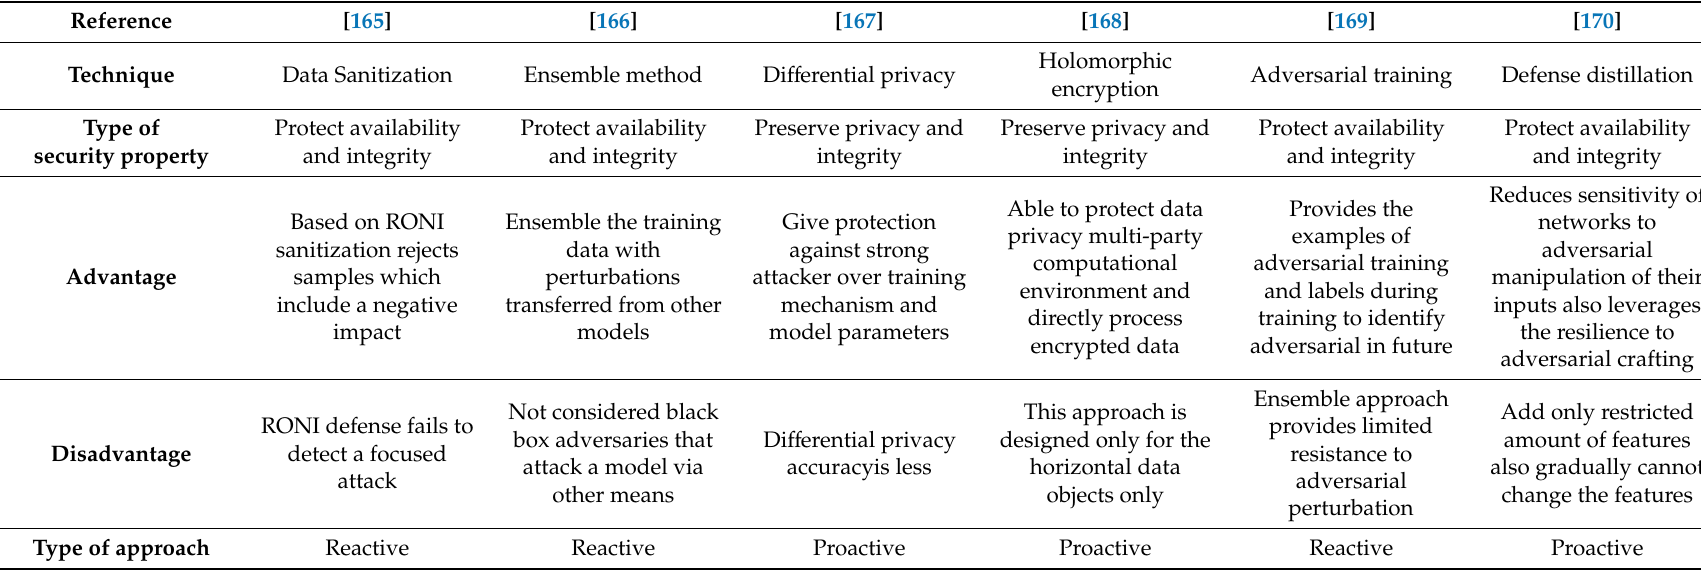
Table 12. Adversarial defense techniques analysis over security properties (reject on negative impact